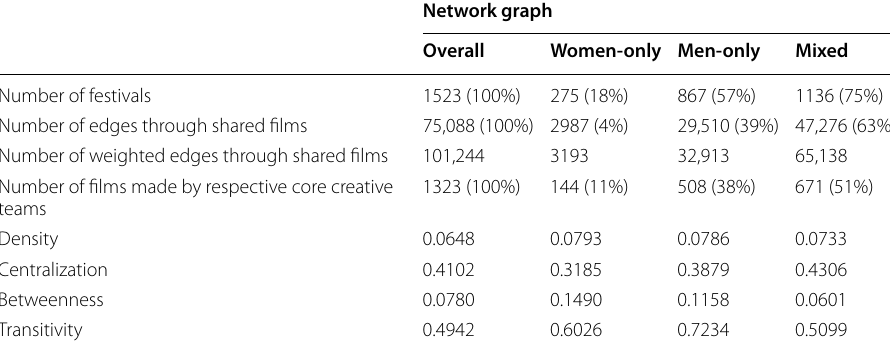
Table 3 Descriptive statistics and global network measures for all network